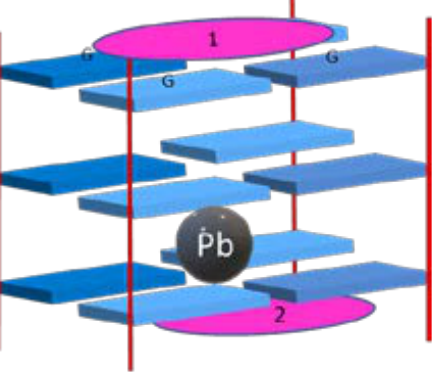
Figure 13. Pb-GQ structure with end-stacking of two Zn II TMPyP molecules (pink ellipses). Later, the interaction of Pt II TMPyP and Pd II TMPyP complexes with